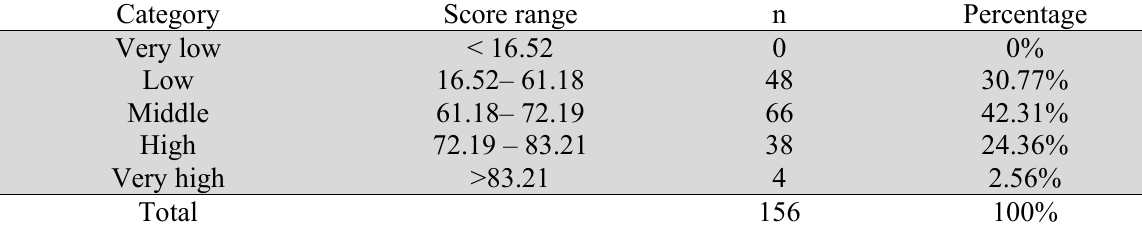
Categorization of interpersonal intelligence score